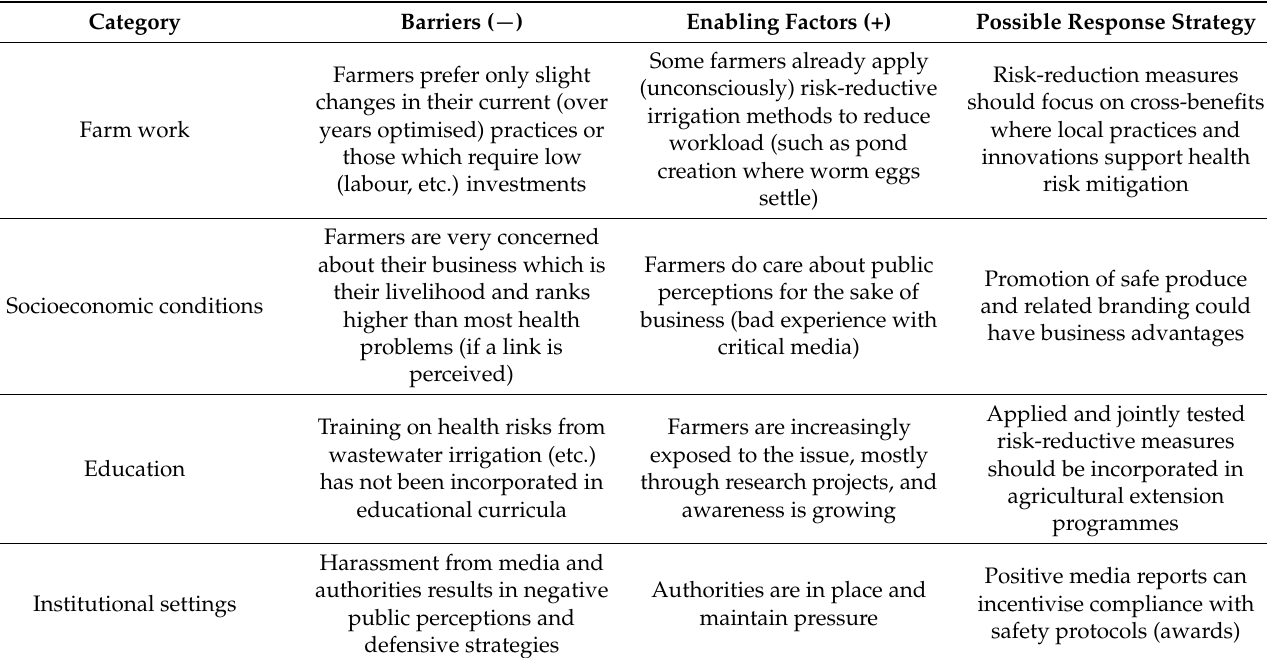
Table 5. Example of external and internal behaviour determinants and possible intervention strategies for vegetable farmers in Ghana (Drechsel and Karg [51],